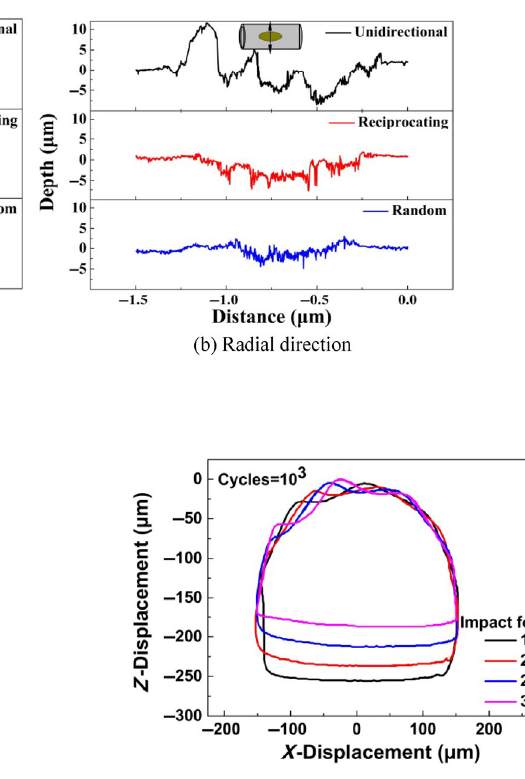
Fig. 15 Wear area and depth of worn wear scars under different motions.